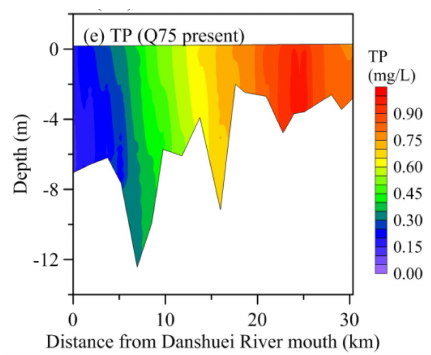
Figure 11. The vertical distribution of the monthly average water quality concentration in the Danshuei River to Tahan Stream under Q75 flow for the present condition ( a ) Salinity; ( b ) DO; ( c ) CBOD; ( d ) NH4; and ( e ) TP.